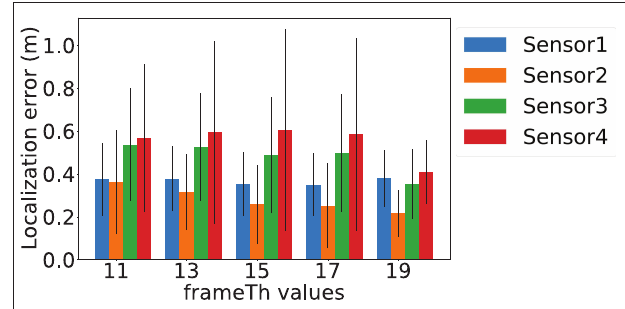
FIGURE 12 | Vision-based footstep event detection parameter frameTh and its impact on localization